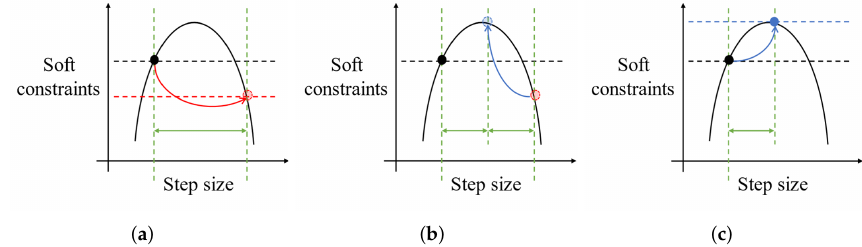
Figure 4. Backtracking line search implementation. ( a ) The first step size of parameter update is colored in red. When the soft constraint values of the updated parameters are smaller than previous ones, ( b ) step size is reduced by half. Modified step size is colored in blue. When the soft constraint values of the updated parameters are greater than previous ones, ( c ), parameters are